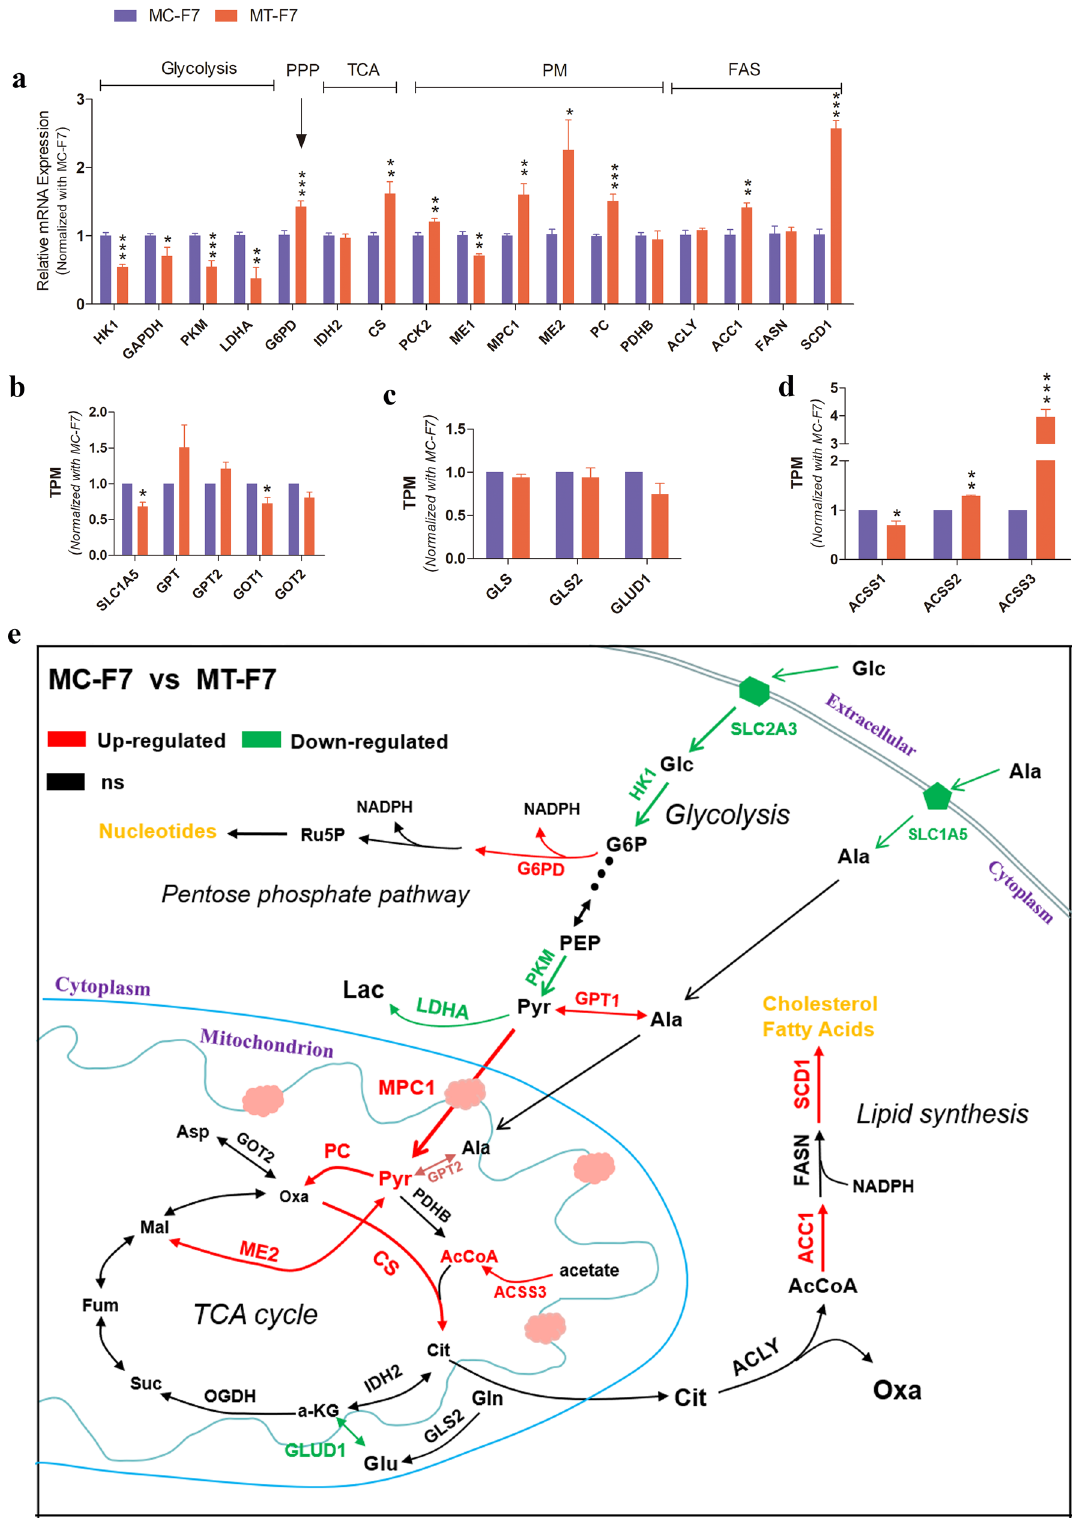
Figure 6. Characterization of central carbon metabolism in the F7 grown on MT-MEFs and MC-MEFs. ( a ) RT-PCR analysis showing the expression levels of the key catalytic enzymes, including rate-limiting enzymes in major metabolic pathways. PPP pentose phosphate pathway, PM pyruvate metabolism, FAS de novo fatty acid synthesis. ( b ) The relative expression of genes encoding catalytic enzymes related to pyruvate metabolism. ( c ) The relative expression of genes encoding catalytic enzymes related to glutaminolysis. ( d ) The relative expression of genes encoding catalytic enzymes related to acetyl CoA (AcCoA) biosynthesis (ACSS family). ( e ) The metabolic diagram shows the differential expression of genes mentioned